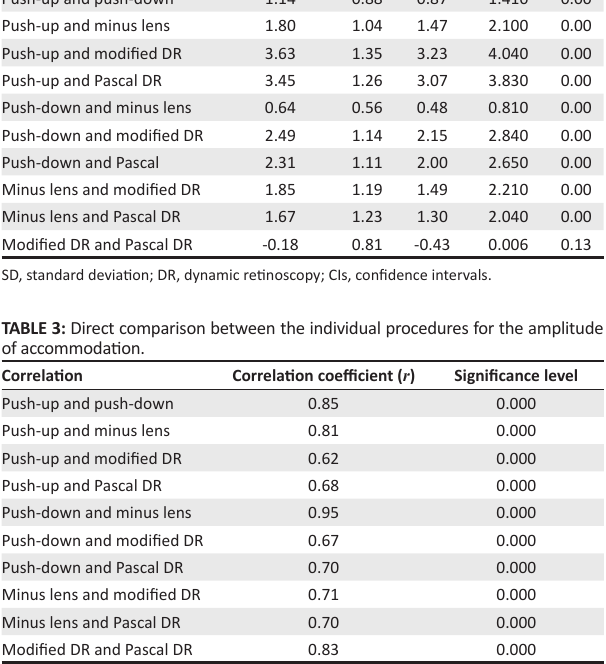
FIGURE 3: Scatter plot comparing the amplitude of accommodation measured subjectively using the push-up and minus lens methods. The correlation coefficient was r = 0.81 ( p =